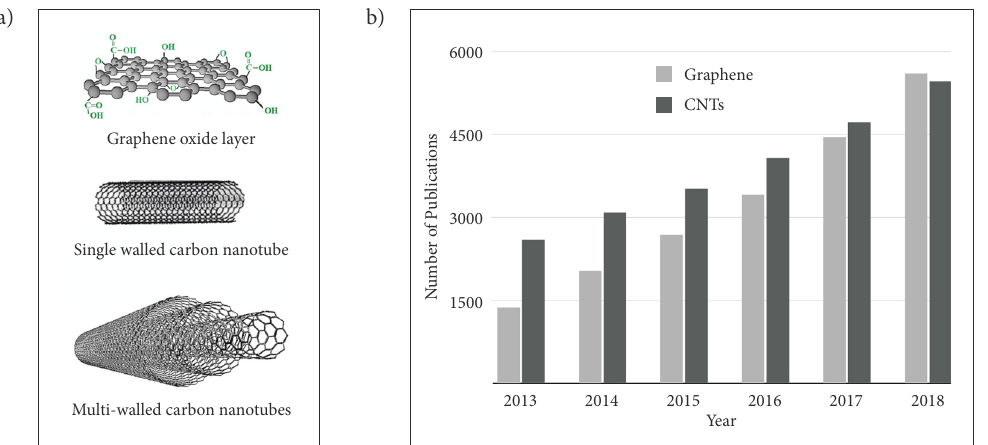
Figure 1. a) – The chemical structure of graphene oxide, single walled CNT and multi-walled CNTs; b) – Number of publications from 2013 to 2018, the data deduced from sciencedirect.com in Jan 2019. (The words used in research filed are polymer, graphene, CNTs, composite, thermal and mechanical